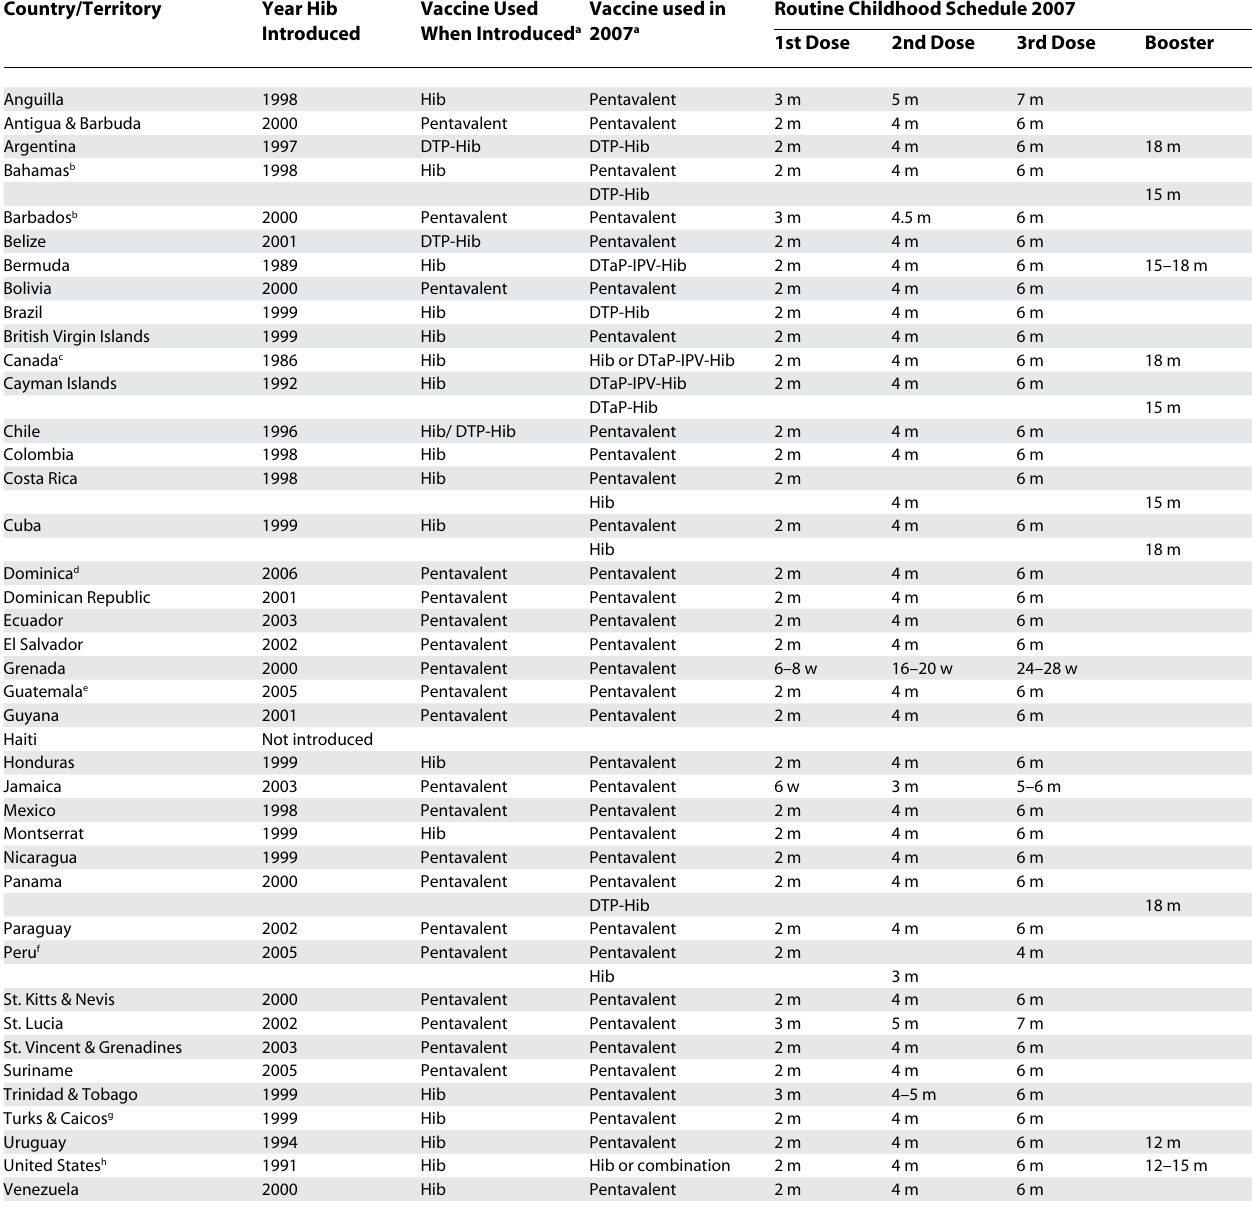
Table 1. Hib Vaccination in the Americas, 1991–2007 Country/Territory Year Hib